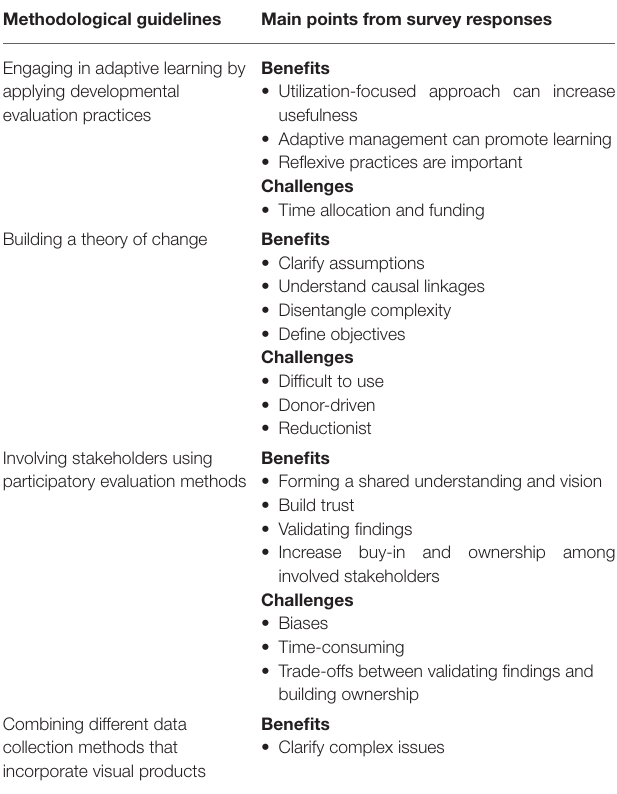
TABLE 6 | Overview of survey